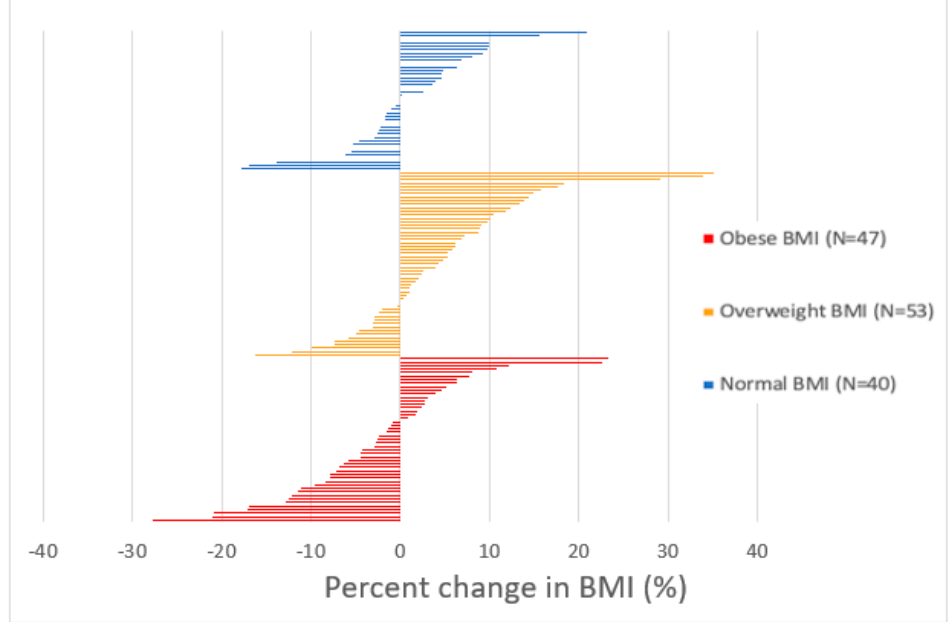
Figure 2. Percent change in BMI from baseline to most recent follow up by BMI group. Each bar represents a single participant. The percent change in BMI among all participants ranged from − 27.73% to +35.17%. Among those with obesity, percent change in BMI ranged from − 27.73% to +23.31%. Among overweight participants, change in BMI ranged from − 16.21% to +35.17%. Among the healthy/underweight BMI group, change in BMI ranged from − 17.84% to 20.86%. Of all participants, 32.1% experienced a ≥ 5% increase in BMI since diagnosis (Figure 3). BMI increases ≥ 5% were observed in 27.5% of the healthy/underweight group, 47.2% of the overweight group, and 19.1% of the group with obesity. We identified a significant association between a ≥ 5% increase in BMI and BMI status at diagnosis (healthy BMI, overweight, obesity) ( χ 2(2) = 9.521, p = 0.009). In particular, the overweight group was more likely to experience a ≥ 5% increase in BMI ( χ 2(2) = 8.83, p = 0.003).